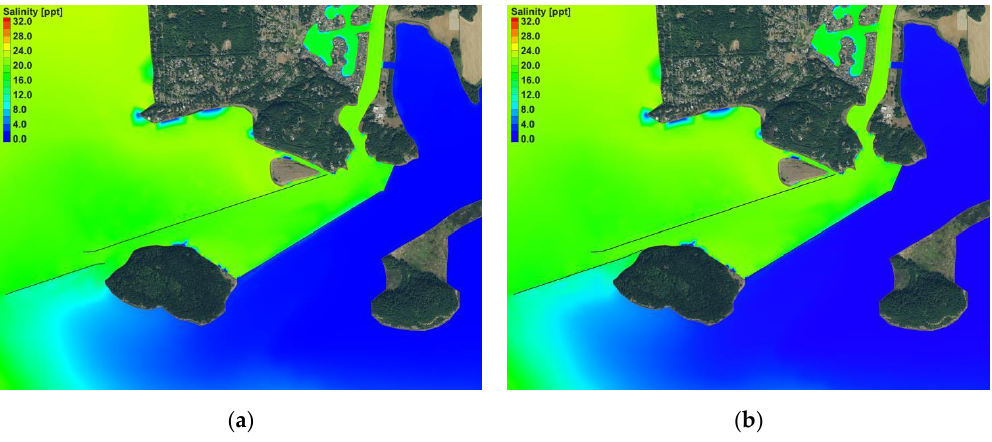
Figure 10. Time averaged salinity distribution (20 days) for ( a ) baseline conditions and ( b ) Jetty Repair Scenario, SCN-1.